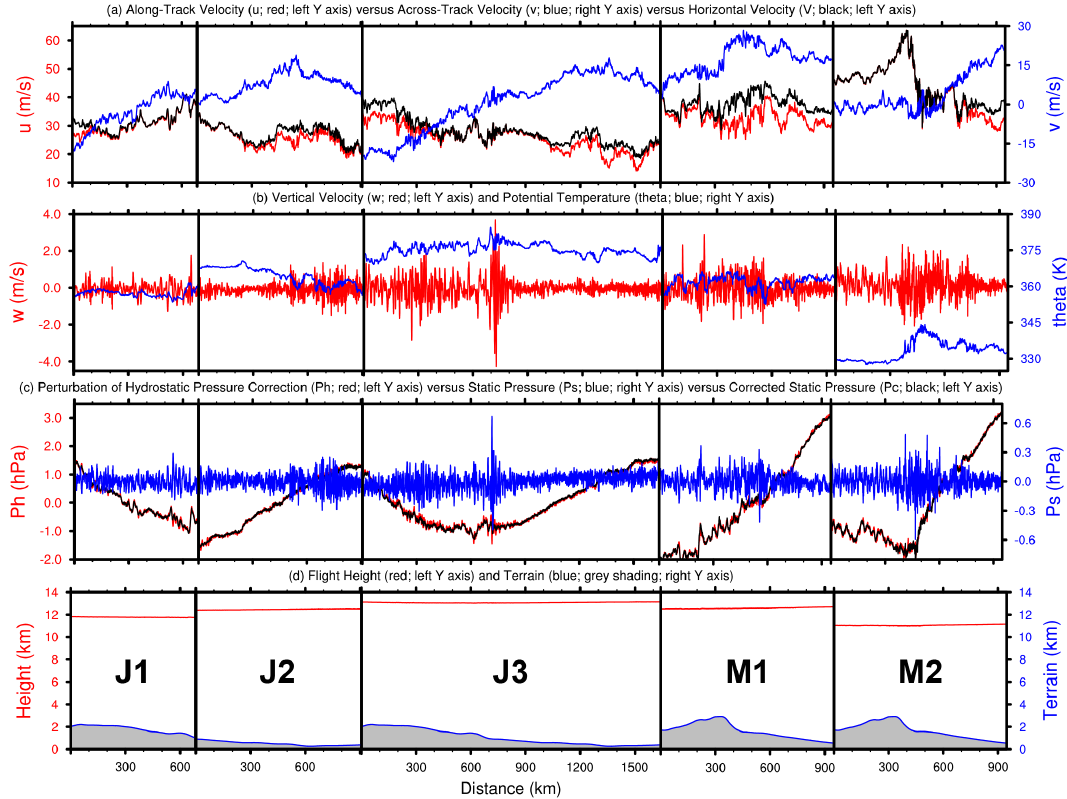
Figure 3. GV flight-level aircraft measurements during five selected segments (from left to right: J1, J2, J3, M1 and M2) of RF02 in START08: (a) along-track velocity component (red; unit in ms − 1 ; left y axis), across-track velocity component (blue; unit in ms − 1 ; right y axis) and horizontal velocity component (black; unit in ms − 1 ; left y axis); (b) vertical velocity component (red; unit in ms − 1 ; left y axis) and potential temperature (blue; unit in K; right y axis); (c) perturbation of hydrostatic pressure correction (red; unit in hPa; left y axis), static pressure (blue; unit in hPa; right y axis) and corrected static pressure (black; unit in hPa; left y axis); and (d) flight height (red; unit in km; left y axis) and terrain (blue; black shading below terrain; unit in km; right y axis). The series in segments J3 and M2 are reversed to facilitate the comparison with J1 + J2 and M1, respectively. Therefore, the orientation of the x axis is from west to east along each flight segment. The distance between minor tick marks in the x axis is 100km. The perturbations in (c) are defined as the differences between the original data and their mean from their corresponding